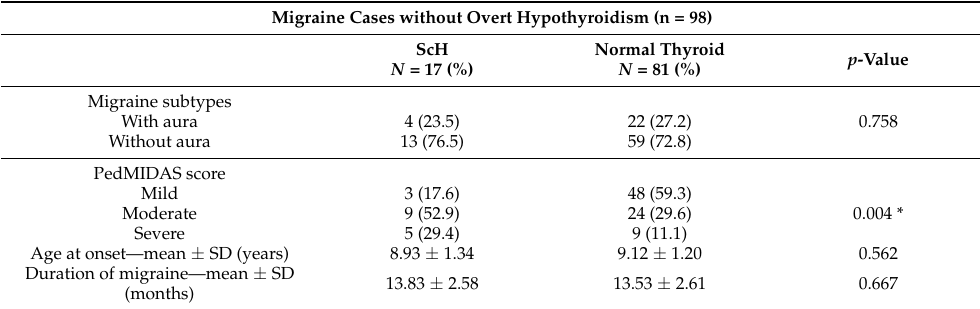
Table 3. Subgroup analysis of migraine cases according to migraine subtypes and severity.